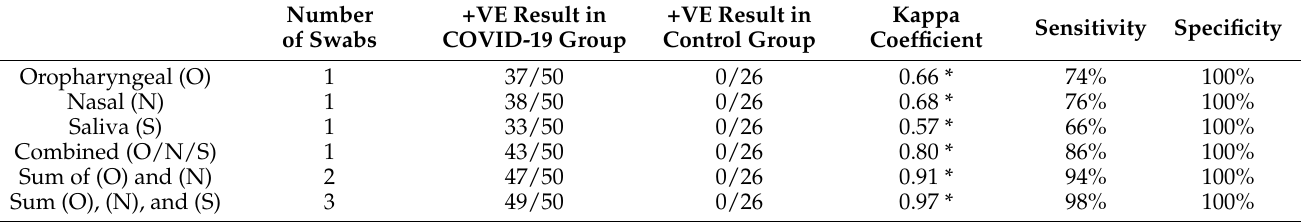
Table 2. The table shows the level of agreement (Cohen’s kappa coefficient), sensitivity, and specificity of COVID-19 antigen testing using different sampling methods in relation to rRT-PCR. The evaluated sampling methods were nasal (N), oropharyngeal (O), extraoral saliva (S), and combined (O/N/S) swabs. Further, the results of the two separate methods (N) and (O), and those of the three separate methods (N), (O), and (S), were